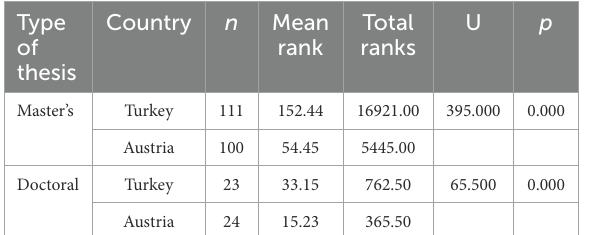
TABLE 6 U-Test results of similarity indexes of master’s and doctoral theses grouped by country.